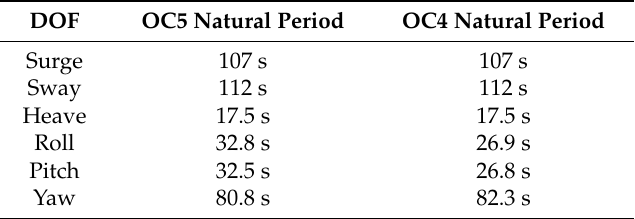
Table 6. Natural period in OC4 and OC5 project.